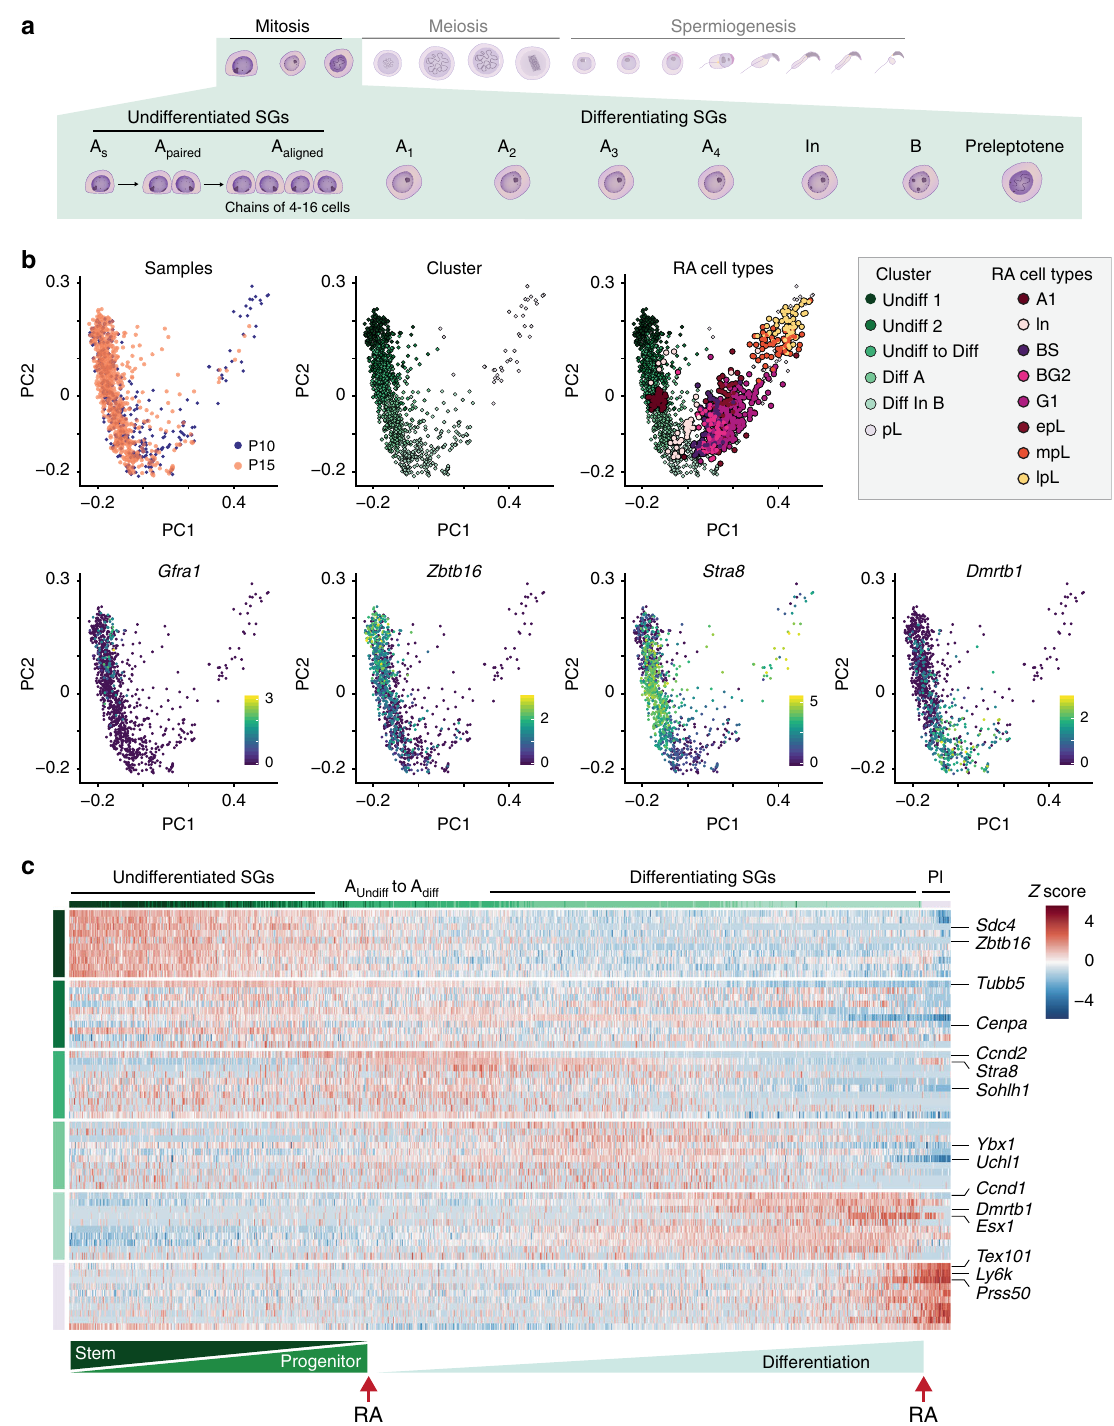
Fig. 3 Cellular heterogeneity during spermatogonial differentiation. a Schematic representation of spermatogonial differentiation including sub-stages of undifferentiated (A s , A paired , A aligned ) and differentiating spermatogonia (A 1 , A 2 , A 3 , A 4 , In, B) (SGs) as well as preleptotene spermatocytes (Pl). b Sub- structure detection in spermatogonia isolated from P10 and P15 animals. PCA was computed on batch-corrected transcriptomes (Methods). The fi rst row highlights the time-point from which a cell was captured (left); the cluster identity based on sub-clustering of the batch-corrected transcriptomes (middle); and the mapping of RA-synchronised cell-types 21 onto our single-cell data (right). Labels for RA-synchronised cells are as described in Fig. 2d. The second row highlights the log 2 -transformed, normalised counts of known marker genes for spermatogonial stem cells ( Gfra1 ), undifferentiated ( Zbtb16 ) and differentiating spermatogonia ( Stra8 and Dmrtb1 ). c Scaled, normalised expression counts of the top 10 marker genes per cell cluster. Column and row labels represent the cell clusters identi fi ed according to ( b ). Cells are ordered along their differentiation course using principal curve regression (Methods). The lower bar indicates the gradual differentiation from undifferentiated spermatogonia to pre-leptotene spermatocytes driven by two retinoic acid (RA)